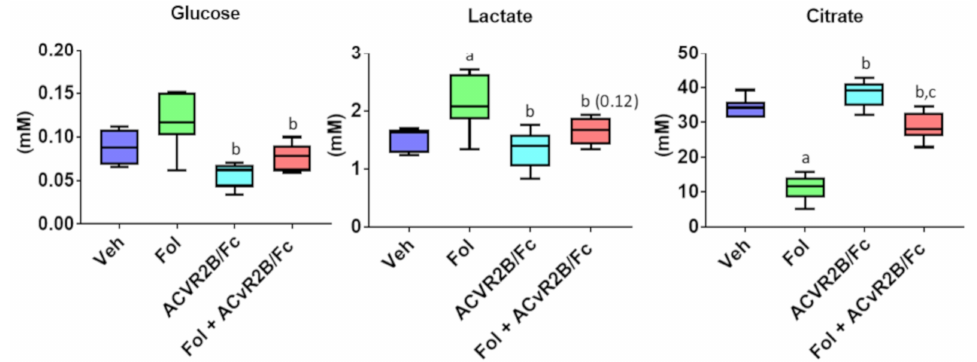
Figure 8. Muscle tissue extract metabolites representing central energy metabolism. Boxplots are shown with mean value, interquartile range, and whiskers that extend to the 10th and 90th percentiles. Significance di ff erences include p -values < 0.05 for a vs. Veh, b vs. Folfiri, c vs. ACVR2B /